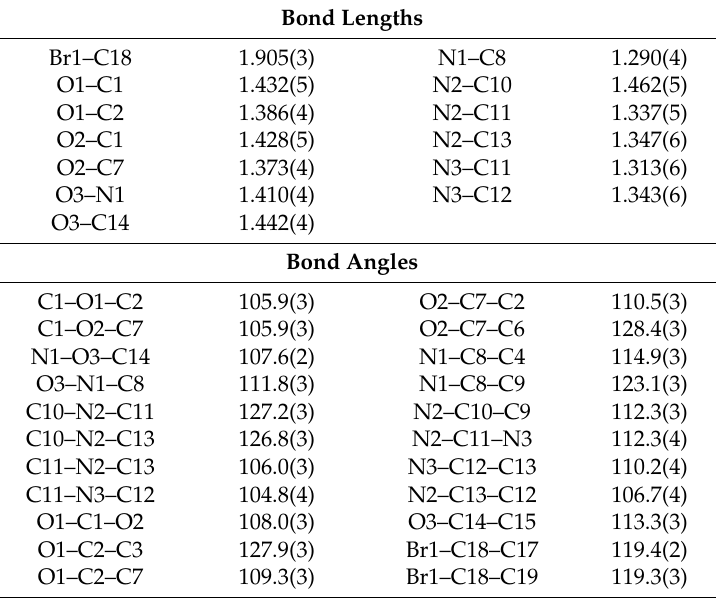
Table 1. Selected geometric parameters (Å, °).